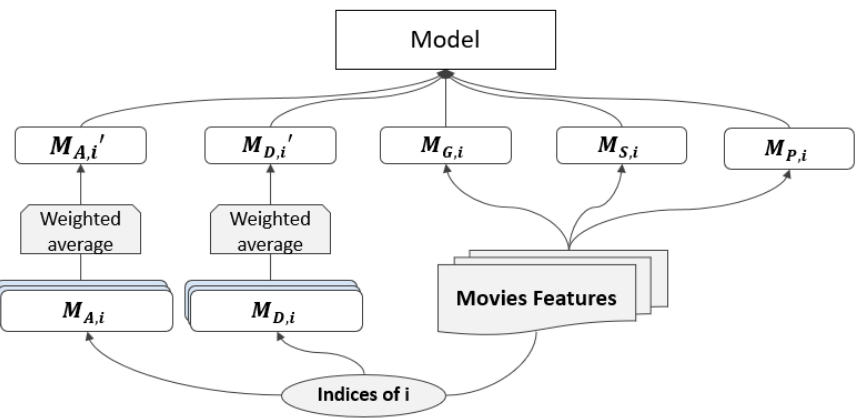
Figure 1. The process of Drafted-Input for Movie being input to the model. 𝒊 is the index for the target movie.